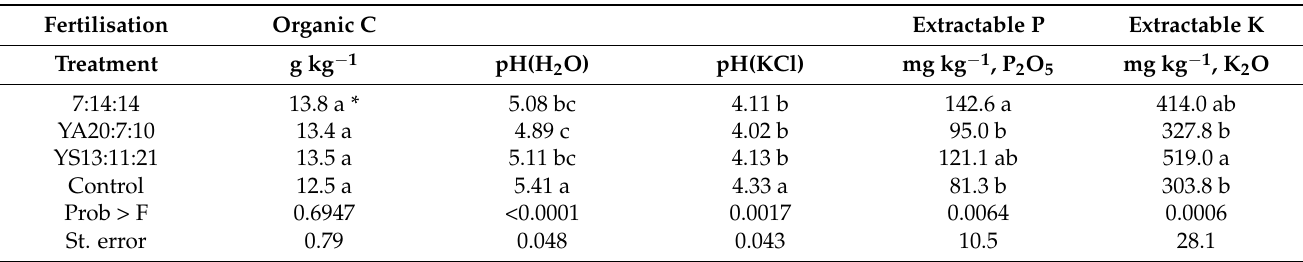
Table 3. Soil organic carbon (C), pH and extractable phosphorus (P) and potassium (K) (Egner-Riehm) as a function of fertilisation treatments.